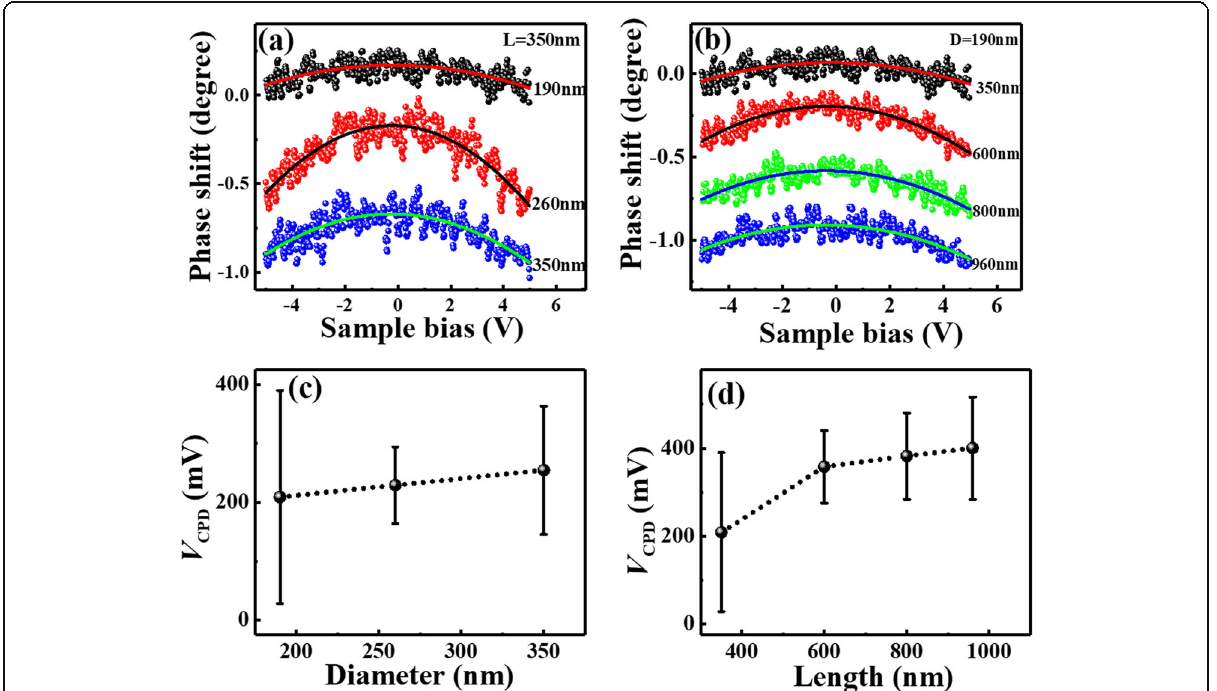
Fig. 7 Δ Φ ~ V curves measured by EFM on individual Si NWs with a different diameters of 190, 260, and 350 nm (length = 350 nm) and b different lengths of 350, 600, 800, and 960 nm (diameter = 190 nm). c and d present the V CPD values obtained by curve fitting as a function of NWs ’ diameter and length. The curves in a and b are vertically shifted for